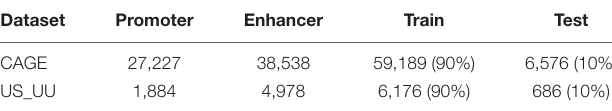
TABLE 1 | Contents of the dataset used in this study. Dataset